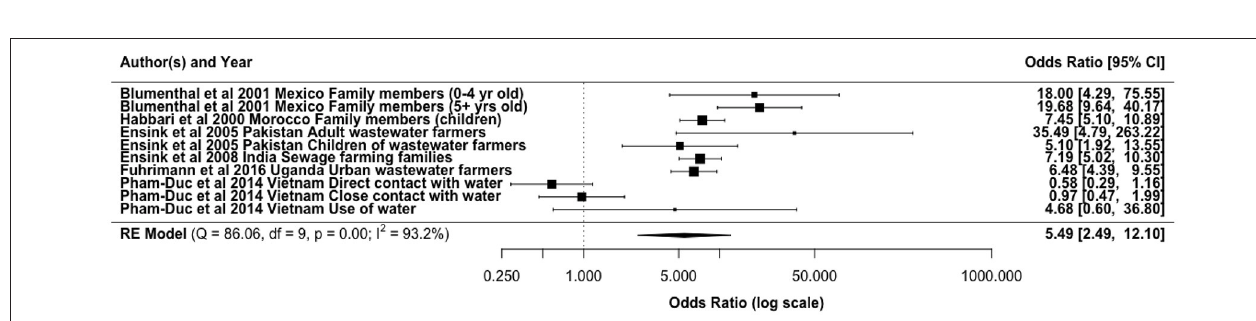
effluents together with hydrophilic ones (194). Norfloxacin and can be highly